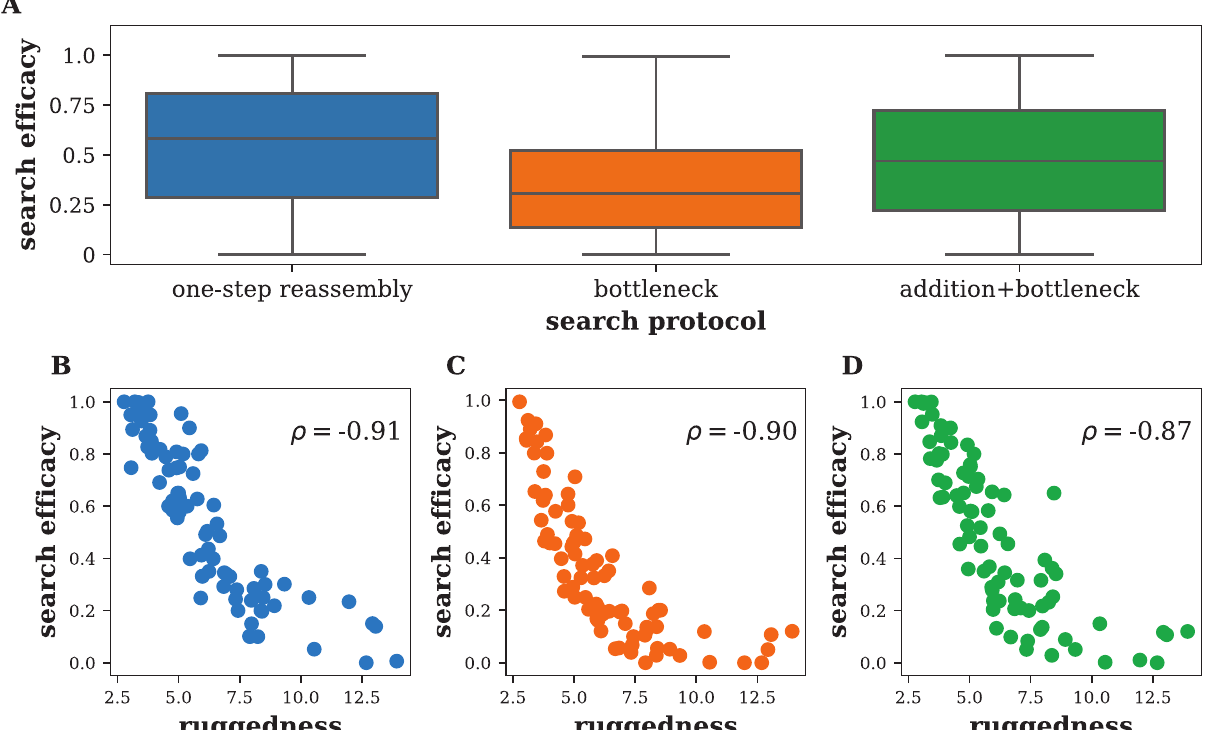
Fig 10. Ruggedness is informative for a variety of search protocols. (A) shows the search efficacy of three different community optimization protocols. Despite differences in the performance of different protocols, ruggedness remained informative of search success across protocols (panels B, C, D). Community function was pair-productivity. All searches started from the best of q = 13 communities. Dilution rate in the dilution-based protocols was adjusted for the highest performance. Simulated communities were the same as in Fig